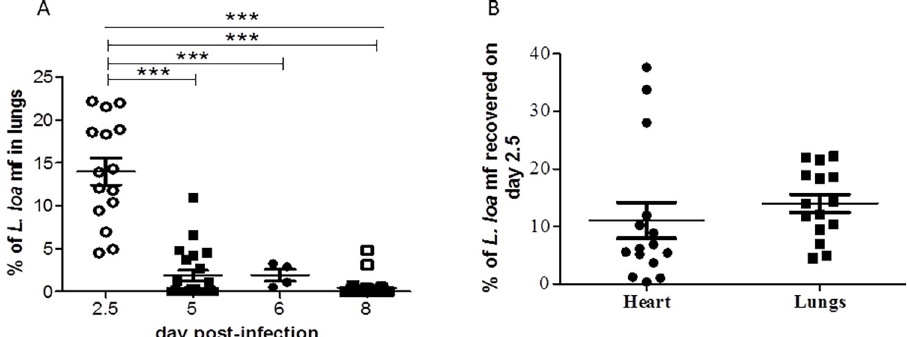
Fig 2. Recovery of L . loa mf in BALB/c mice. (A) Mice were infected intravenously with L . loa mf and the lungs were analyzed on various days post-infection. (B) L . loa mf analyzed in the heart and lung tissues of mice 2.5 days post- infection. Male and female mice were used. ��� p < 0.001.